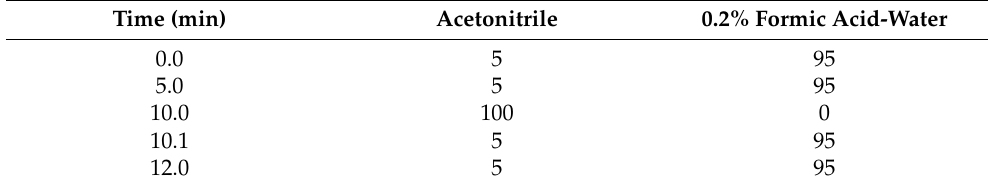
Table 9. Linear gradient elution procedure of simvastatin and simvastatin hydroxy acid. Time (min) Acetonitrile